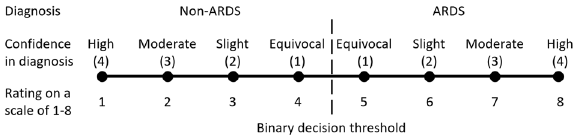
Fig. 5 The ARDS assessment scale. A score of 1 indicates an absolute certain assessment as a non-ARDS chest X-ray,